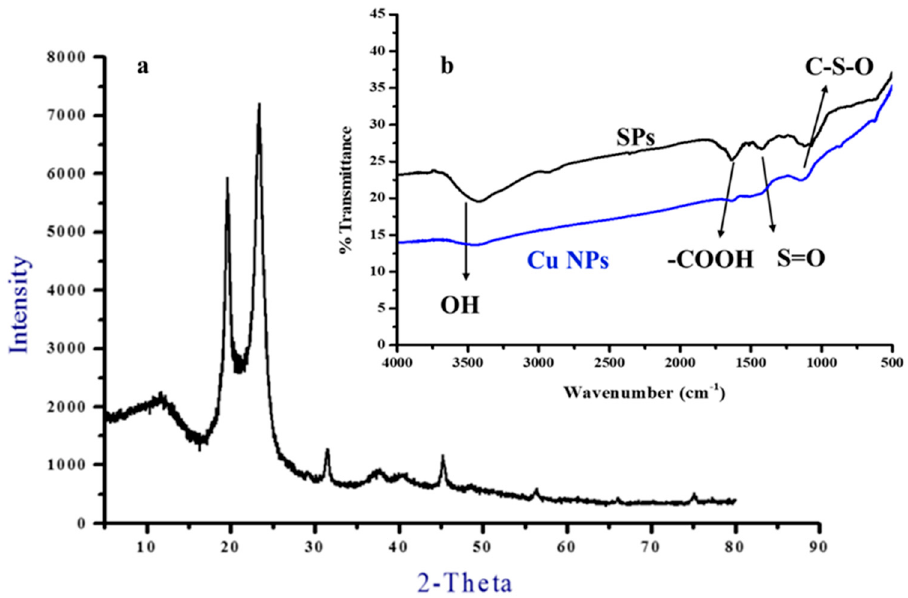
Figure 3. XRD pattern ( a ) of Cu NPs and FTIR spectra ( b ) of SPs and Cu NPs.